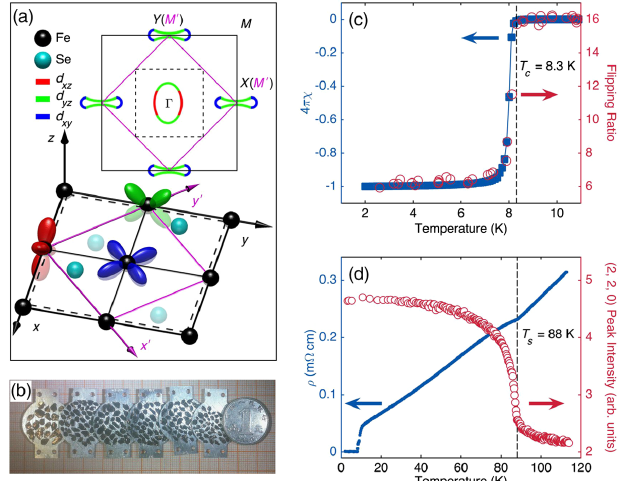
FIG. 1. Crystal structure, FS topology, and characterization of phase transition temperatures in FeSe single crystals. (a) Crystal structure and FS topology [20], with orbital characters color coded with the orbital shapes. Three Brillouin zone notations are shown for comparison: 1-Fe unit cell (black solid lines), 2-Fe unit cell (magenta solid lines), and 4-Fe unit cell (dashed lines, used throughout our presentation). (b) Photograph of our INS sample before the final assembly. (c) dc magnetic susceptibility χ shows a 8 . 3 K in zero-field- sharp superconducting transition at T c ¼ cooled measurement in a magnetic field of H ¼ 10 Oe applied parallel to the ab plane. A consistent transition is observed for the entire INS sample using depolarization effect on the neutron beam. (d) Resistivity ρ shows an abrupt change in slope versus T 88 K, below which an at the nematic transition temperature T s ¼ abrupt increase in the (2,2,0) Bragg scattering intensity is observed due to reduced extinction